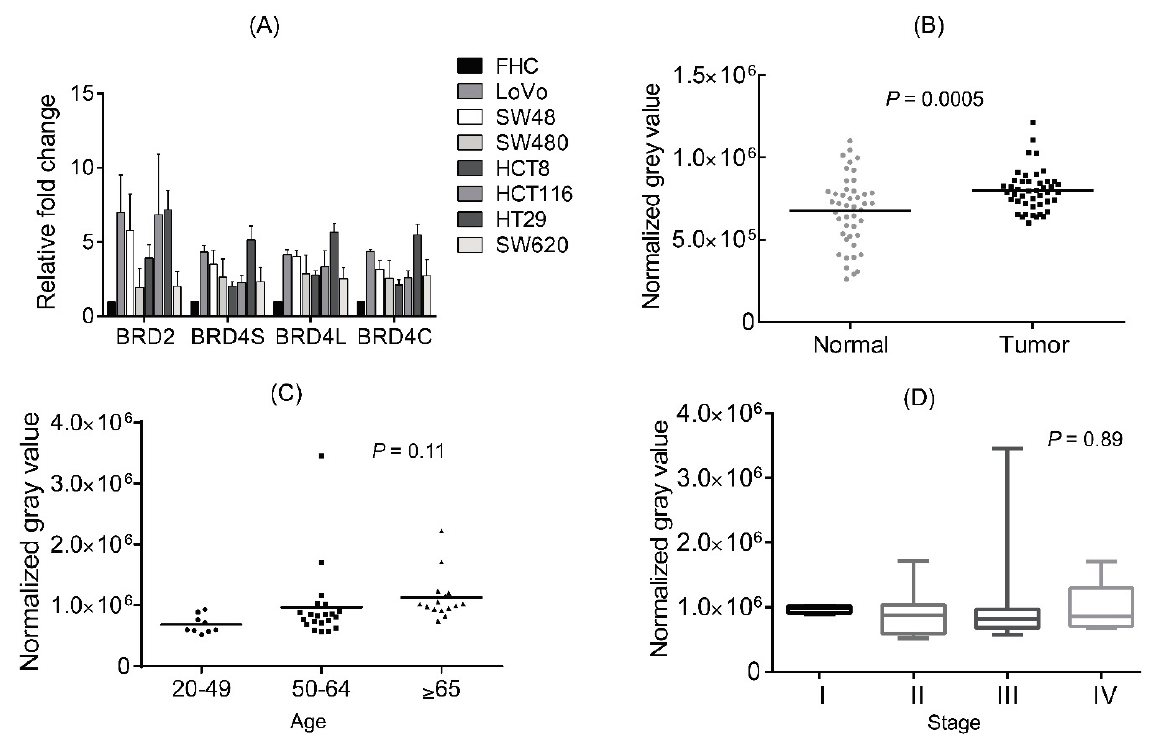
Figure 1. BRD4 is highly expressed in colorectal cancer (CRC). ( A ) mRNA expression levels of BRD2, BRD4 short isoform and BRD4 long isoform in normal colon epithelial cell lines and colon cancer cell lines; ( B ) Protein levels of BRD4 in normal and colon cancer human tissues (tumor and healthy control); ( C ) Protein levels of BRD4 according to different ages; ( D ) Protein levels of BRD4 according to the stage of CRC (per AJCC guidelines). BRD4S: BRD4 short isoform; BRD4L: BRD4 long isoform;